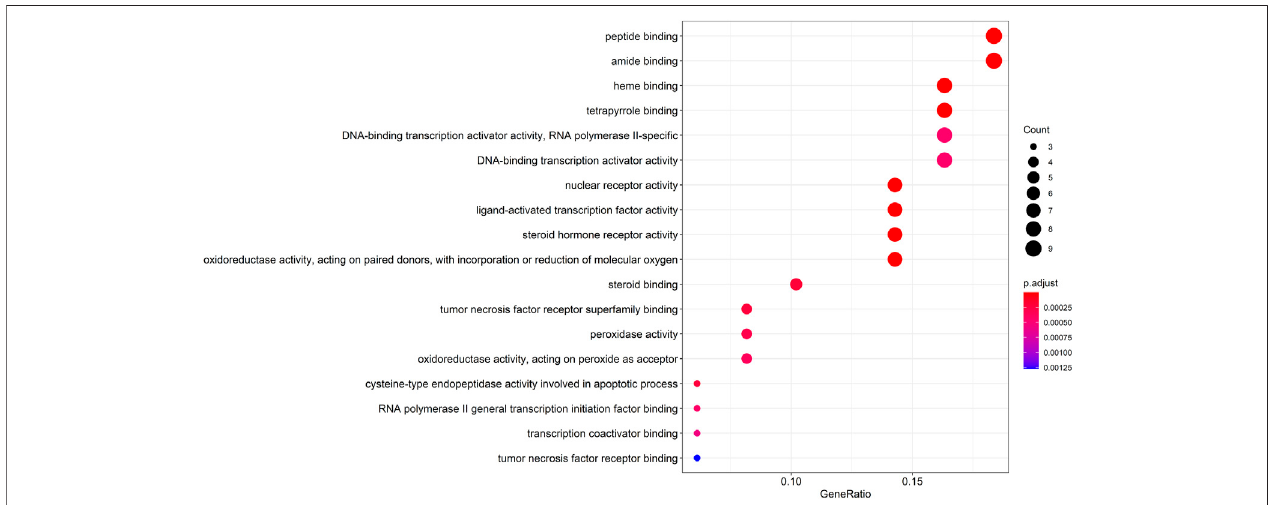
FIGURE 4 | The top 18 remarkably enriched GO analysis for biological function of potential target genes of WP in RA.